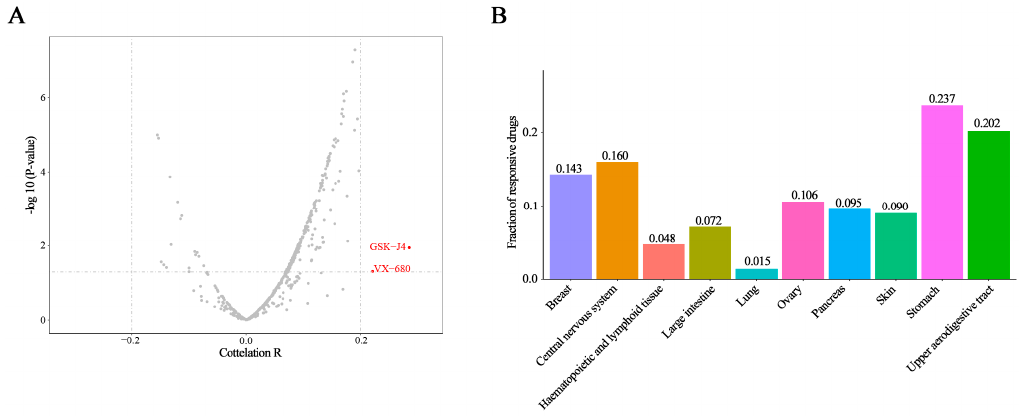
Figure 5. STAT3 expression and drug response correlation. ( A ) The volcano plots showed the correlation coefficient ( x -axis) and − log10 p -value ( y -axis) between STAT3 expression and drug response in 823 cancer cell lines and 545 drugs. The red dots were the drugs with a correlation coefficient greater than 0.2 and a p -value less than 0.05. ( B ) The histogram showed the ratio of drugs with a correlation coefficient greater than 0.3 and a p -value less than 0.05 in 10 cancer cell line types. In breast cancer, abiraterone, targeting CYP17A1, was negatively correlated with STAT3 ( r = − 0.969) to the greatest extent compared with other compounds. In other words, STAT3 expression was correlated with sensitivity to abiraterone in breast cancer cell lines. Abiraterone not only was approved by the FDA for the treatment of prostate cancer but also displayed the potential benefit for breast cancer [40,41]. Additionally, the probe bafilomycin A1, the target of ATP6V0A1, showed the highest correlation coefficient ( r = − 0.999) in skin cancer. Bafilomycin A1 is a promising candidate drug targeting growth, apoptosis, and metastasis in cancer cell lines [42,43], and it can also reduce cell viability by inducing autophagy in melanoma [44]. The data showed that STAT3 expression was correlated with sensitivity to bafilomycin A1 in skin cancer cell lines, and STAT3 might play a role in autophagy in skin cancer. In upper aerodigestive tract cancer cell lines, JW-55, which was the probe targeting TNKS, had a positive correlation coefficient of 0.998. JW-55 was the selective Wnt/ β -catenin signaling pathway inhibitor [45], and STAT3 was also approved to regulate Wnt/ β -catenin signaling in the development of cancer [46]. The strong correlation between STAT3 and JW-55 was likely explained in this way. While JW-55 showed a negative correlation ( − 0.655) with STAT3 expression in large intestine cancer, the difference might be owing to the fact that STAT3 expression was varied among different cancer cell lines. Among these, we also found the drug cerulenin targeting FASN in stomach cancer was correlated with STAT3 positively ( r = 0.555). As an inhibitor of fatty acid synthase, cerulenin could affect the proliferation and metastasis of cancer cells [47]. Hence, these results suggested that STAT3 might regulate lipid homeostasis in stomach cancer. Several compounds were targeting the PI3K/AKT pathway, such as rigosertib, MK-2206, AZD6482, TGX-221, NVP-BEZ235, and targeting the JAK/STAT pathway, like ruxolitinib and AZD1480, which were significantly correlated to STAT3 expression in cancer cell lines. Consistent with our data, STAT3 was involved in the PI3K signaling pathway in cancer [48]. To further investigate the potential mechanism of phytochemical approaches to cancer treatment, we summarized the correlation between transcriptional expression level of STAT3 and sensitivity to natural compounds in cancer cell lines by CCLE and CTRP databases (Table 2). We found that STAT3 expression was significantly correlated with natural product betulinic acid, phloretin, nakiterpiosin, and cucurbitacin I. Among them, betulinic acid, which had the negative